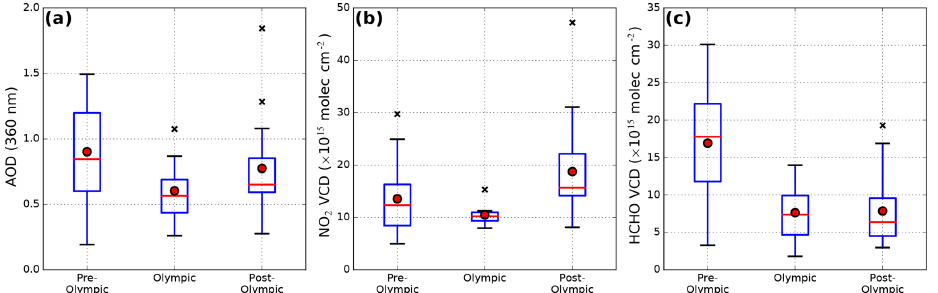
Figure 14. Boxplots of (a) aerosol optical depths, (b) NO 2 and (c) HCHO VCDs before, during and after the Youth Olympic